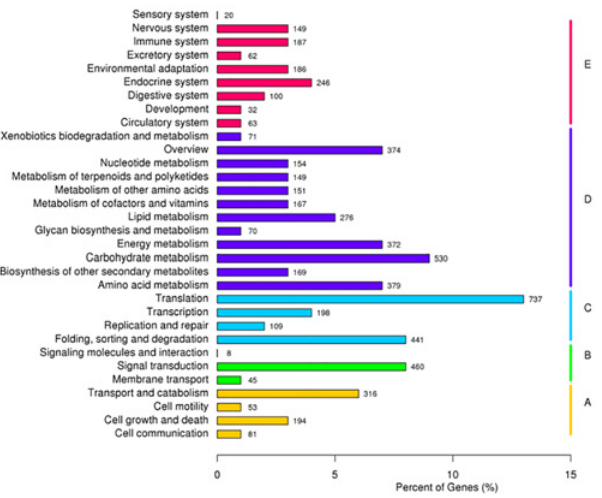
Fig 2. Pathway assignment based on the Kyoto Encyclopedia of Genes and Genomes (KEGG). (A) Classification based on cellular process categories, (B) classification based on environmental information processing categories, (C) classification based on genetic information processing categories, (D) classification based on metabolism categories, and (E) classification based on